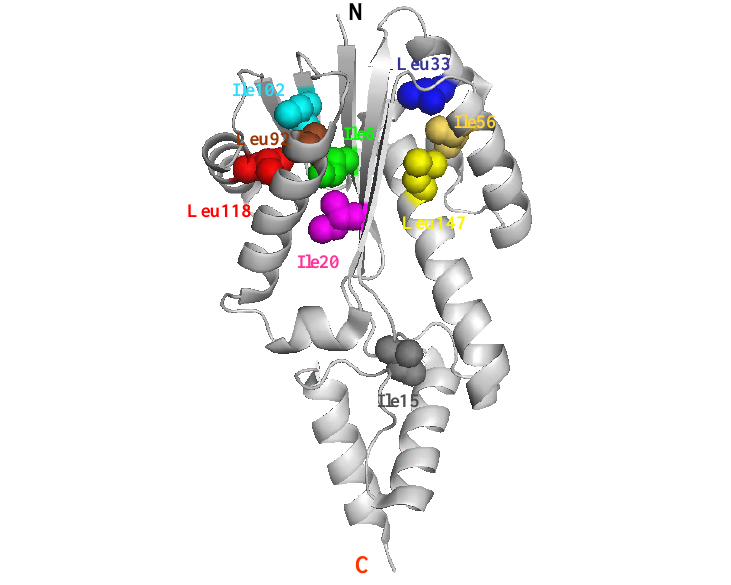
Figure 8. Crystal structure of Tk-RNase HII, depicting the side chains of Ile and Leu that have been substituted. Figure is reproduced from